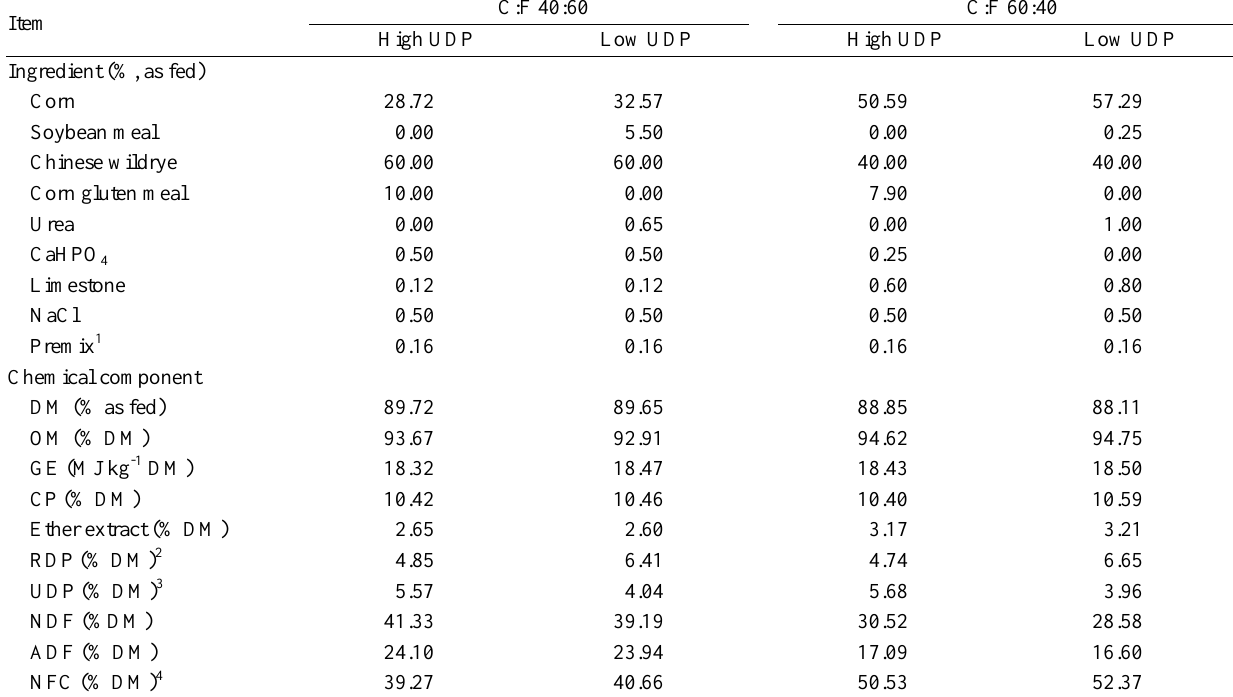
Table 1. Ingredient and chemical composition of experimental diets (% of